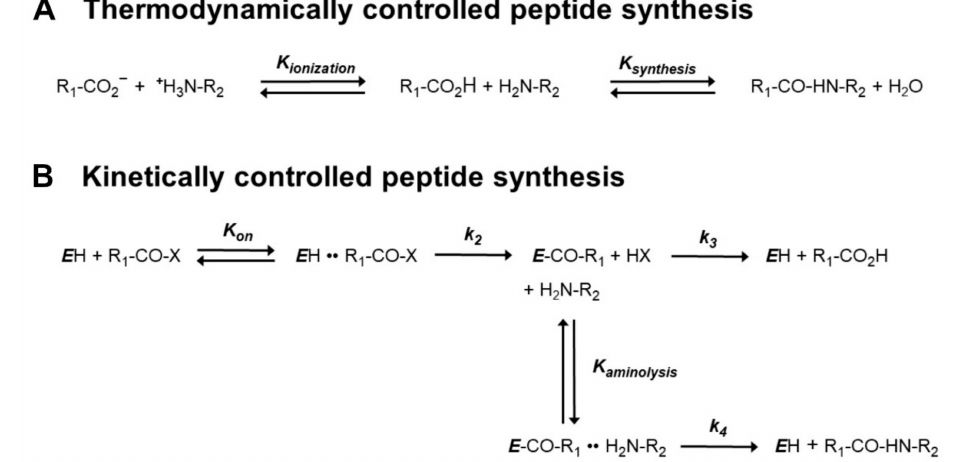
Figure 2. Thermodynamic and kinetic control of peptide bond synthesis with protease catalysts. ( A ) Thermodynamic or equilibrium control dominates in catalysis by natural ligases or in organic media with low water content that shifts the chemical equilibrium. ( B ) Kinetic control is mostly achieved by synthetic precursors of peptides or proteins, containing a derivative of the C-terminal carboxylate with a good leaving group, such as carboxy esters of the residue with methanol (MeOH) and various other alcohols, as well as corresponding thioesters and thiols as leaving moieties. The formation of an acyl intermediate with serine or cysteine proteases is required